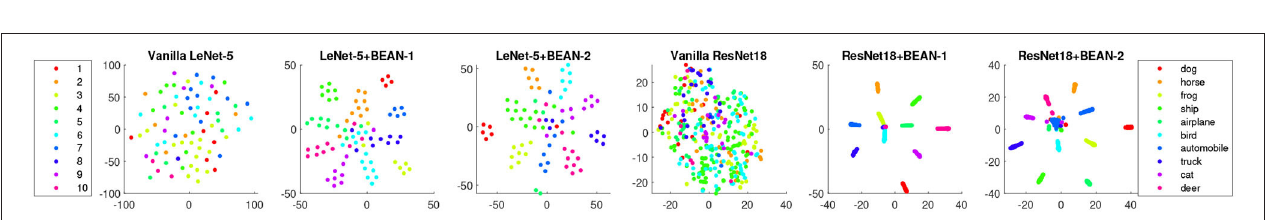
FIGURE 3 | Neuron co-activation patterns found in the representation of the last dense layer of LeNet-5 + BEAN-2 model on MNIST dataset. The dimensionality of neurons’ weight space was reduced to 2D with T-SNE for visualization. Each point represents one neuron within the last dense layer of the model and is colored based on its activation scale. The 10 subplots show the average activation heat-maps when each digit’s samples were fed into the model. The warmer color indicates a higher neuron activation.